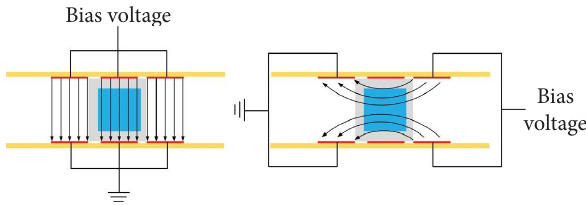
Figure 4: Te electric feld distribution diagram.